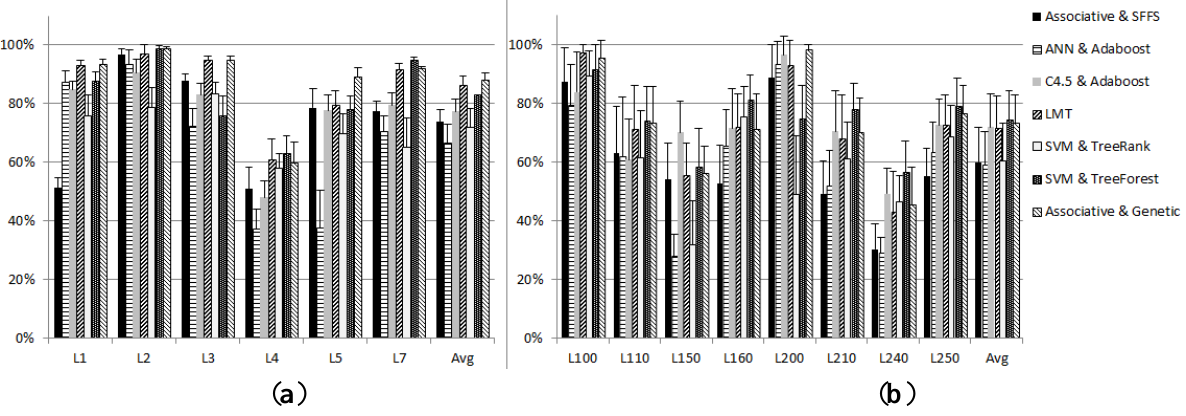
Figure 10. MAP results for comparative experiments for ranking images by semantics using different ranking methods on ( a ) the UCI Statlog Landsat data set and ( b ) WROC data